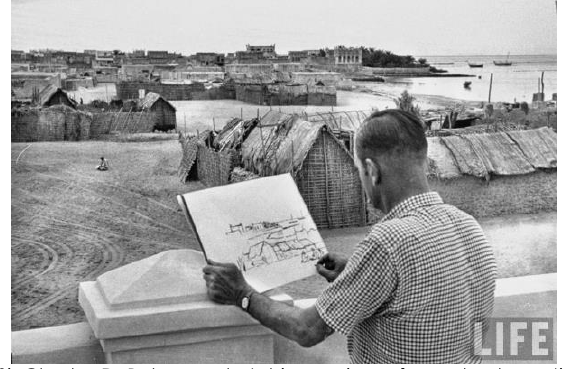
Sir Charles D. Belgrave sketching a view of wooden barastis in Manama. Photographed by Walter Sanders, 1952